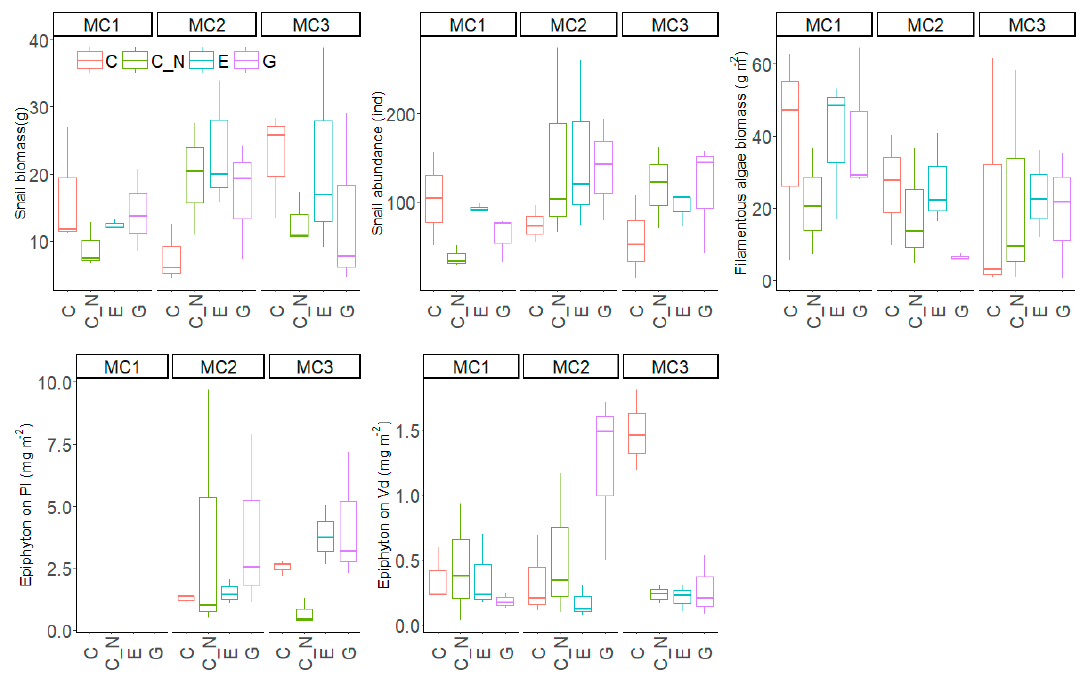
Figure 5. Snail biomass and abundance, biomass of filamentous algae and epiphyton on two submerged macrophytes at the end of the experiment for the three macrophyte community treatments (MC1, MC2 and MC3) and the four extreme precipitation treatments (EP: C, C_N, E and G). Pl = Potamogeton lucens ; Vd = V. denseserrulata . Table 3. Statistical summary of two-way ANOVA on the effects of macrophyte community (MC: MC1, MC2 and MC3) and extreme precipitation (EP: C, C_N, E and G) on the biomass (or abundance) of filamentous algae, snails and epiphyton at the end of the experiment. NS = not significant; * = p < 0.05; *** = p < 0.001. Two-Way ANOVA Indicators MC EP F Values, Sig. F Values, Sig.